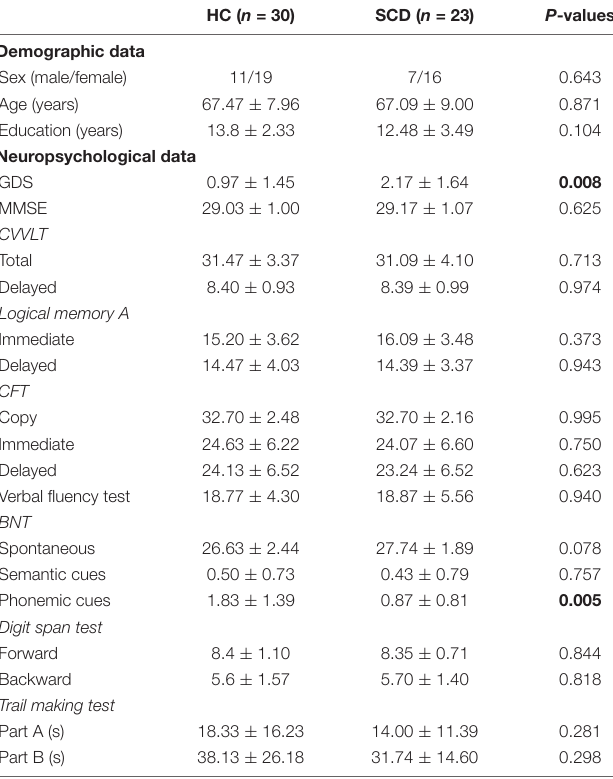
TABLE 1 | Demographic variables and neuropsychological measures as mean ± SD.